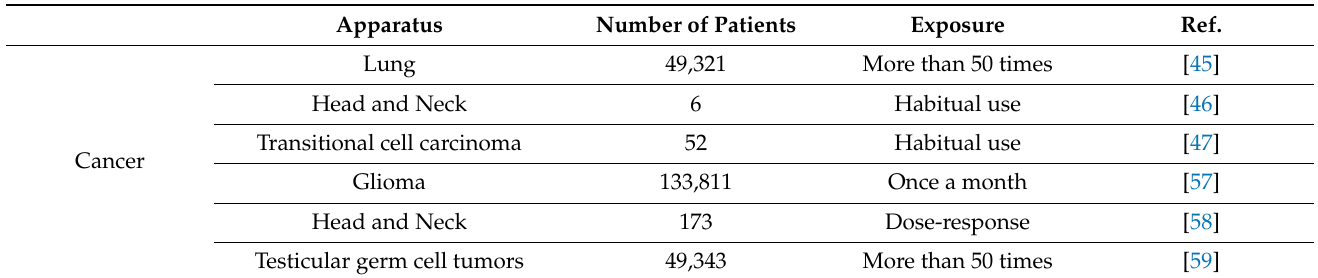
Table 2. Carcinogenic potential of Cannabis and CBs reported in clinical